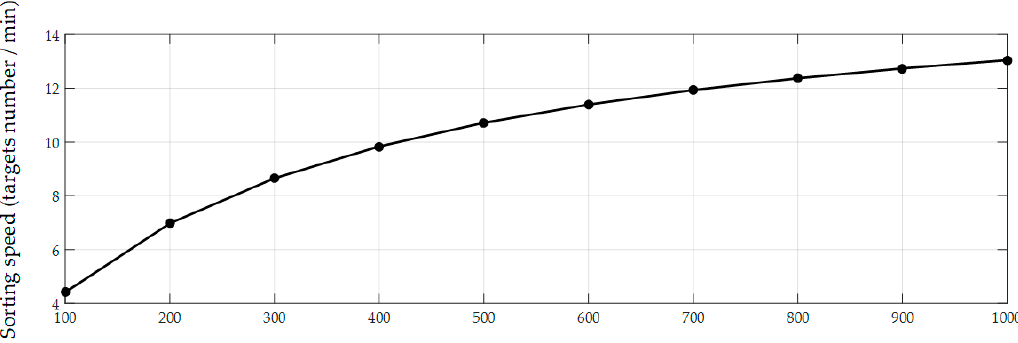
Figure 15. Plot of sorting speed versus different target number.